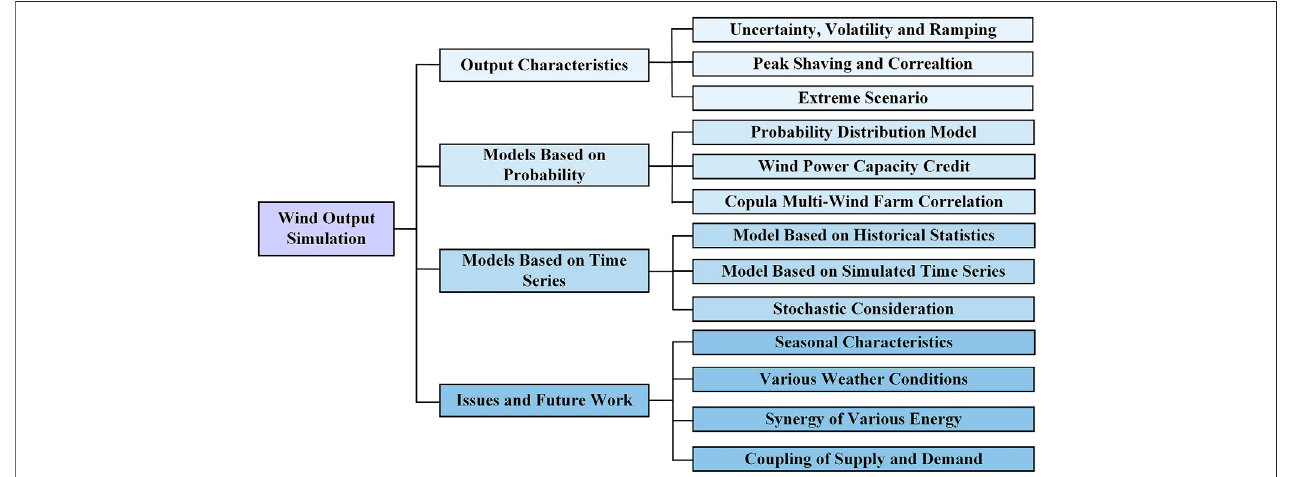
FIGURE 2 | Structure of this